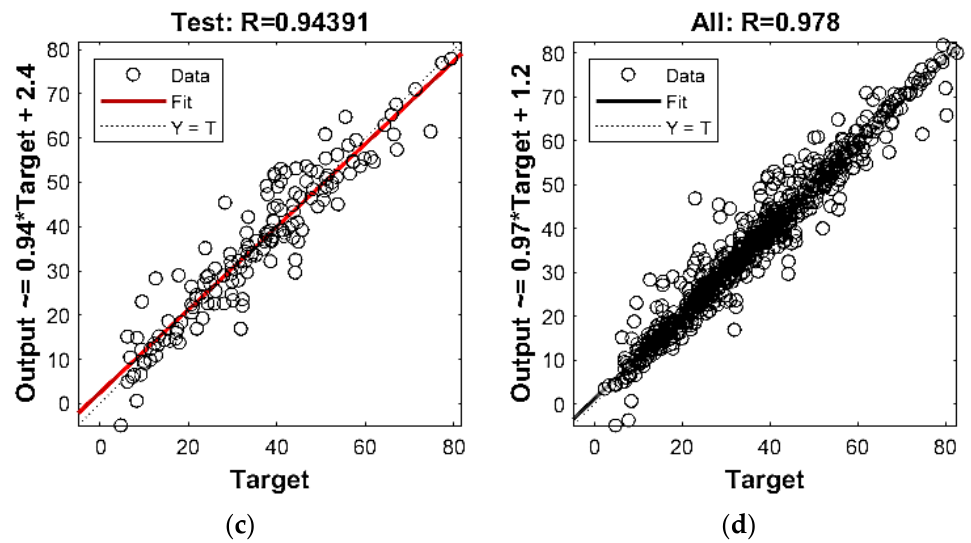
Figure 17. Two hidden layers ((60 3) number of neurons in hidden layers with activation function) neural network training regression ( a ) Training regression; ( b ) Validation regression; ( c ) Test data regression; ( d ) Combined regression of training, validation and test data.